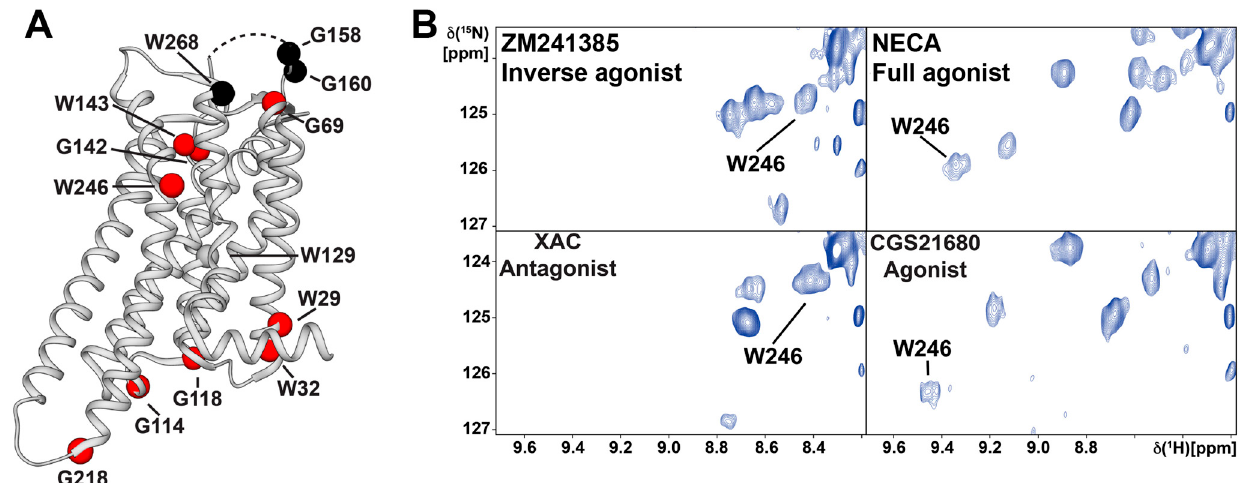
Figure 5. Spectral region containing the Trp246 6.48 indole 15 N– 1 H signal of 2D [ 15 N, 1 H]-TROSY correlation spectra of [u- 15 N, ~70% 2 H]-A 2A AR in complexes with ligands of different efficacies. ( A ) Locations of glycines and tryptophans in the crystal structure of A 2A AR in complex with the inverse agonist ZM241385 (PDB: 3PWH), for which NMR signals were assigned. Assigned residues which show a response in their NMR signals to bound ligands with different efficacies are depicted by red spheres. Residues that showed no response are depicted by black spheres. The disordered portion of the ECL2 that was not observed in the crystal structure is shown as a dashed line. ( B ) The indole 15 N– 1 H NMR signal of the toggle switch tryptophan W246 6.48 is highly responsive to variable drug efficacy, as observed by comparing the spectra for A 2A AR in complexes with the inverse agonist ZM241385, the antagonist XAC, the selective agonist CGS21680 and the full agonist NECA. (Adapted from Figure 4D in reference [88] ).